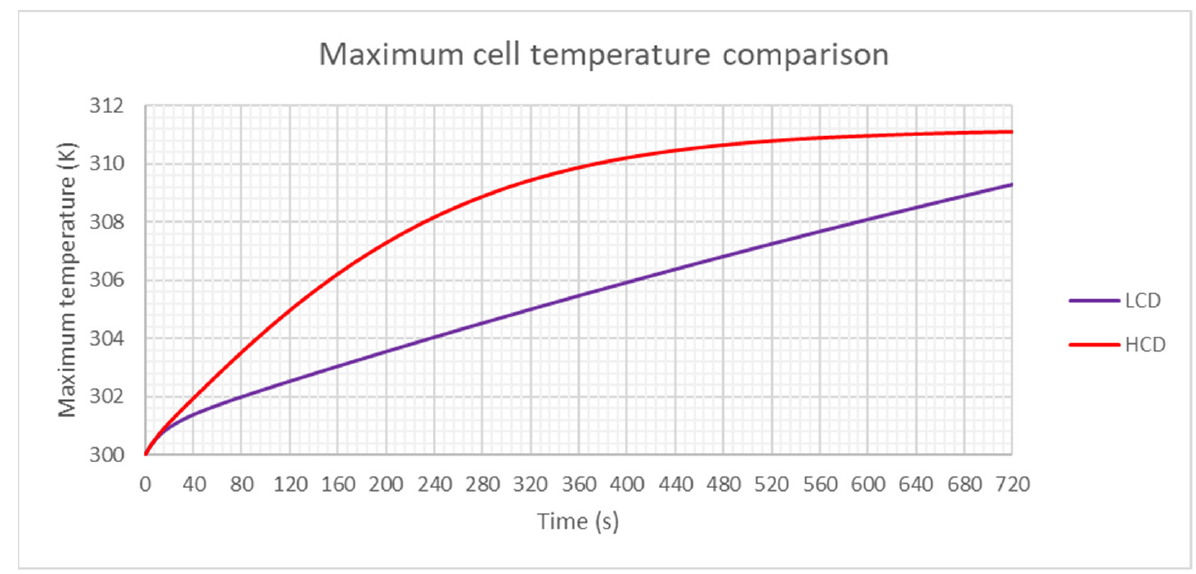
Figure 19. Maximum cell temperature comparison–LCD & HCD.